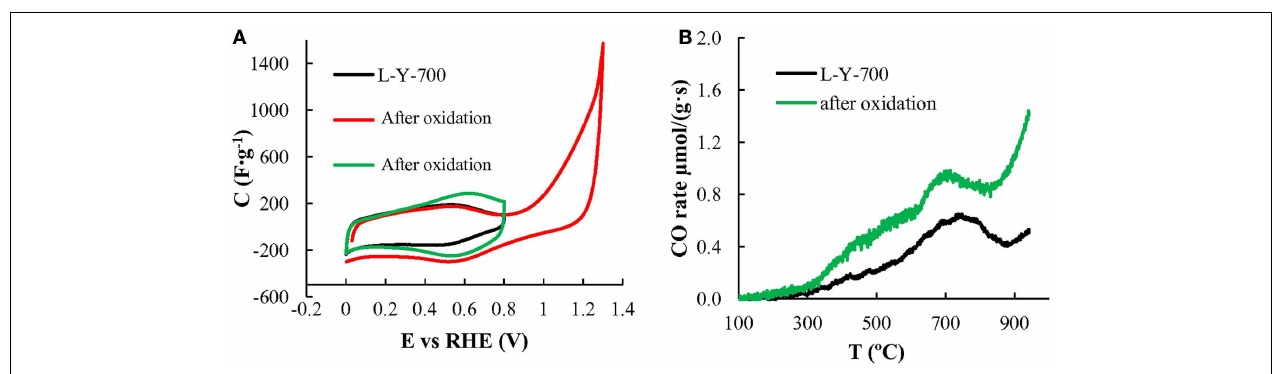
FIGURE 9 | (A) Cyclic voltammograms of L-Y-700 before oxidation and after oxidation between 0 and 1.2V and between 0 and 0.8V (B) COTPD evolution profiles obtained from L-Y-700 before and after the electrochemical oxidation treatment, adapted from Ruiz-Rosas et al.